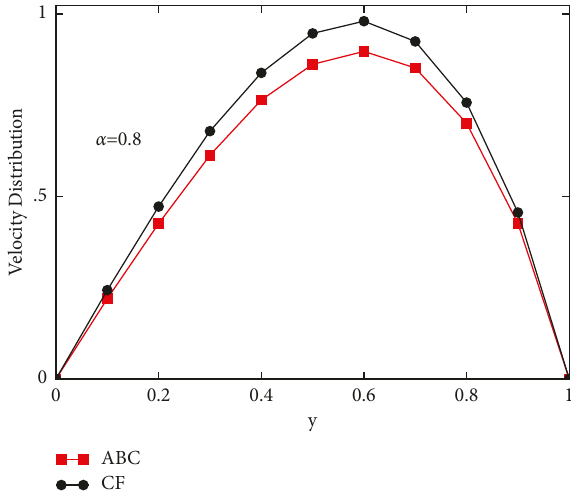
Figure 2: Correlation between the velocities through CF [37] and present, when Pr and β 0 . 8. (cid:30)